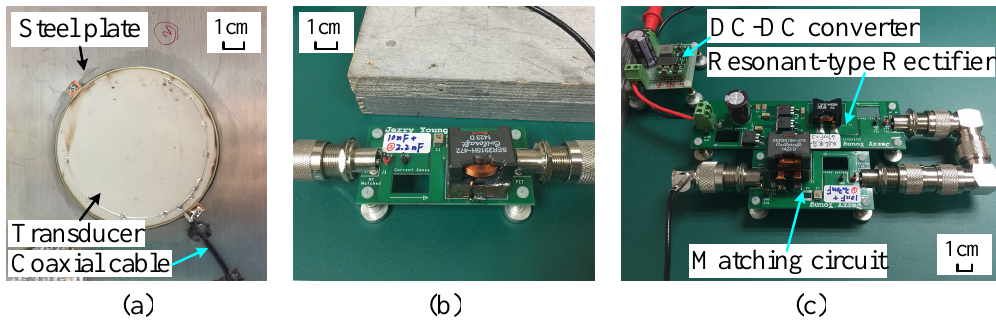
Figure 11. ( a ) One of the transducers; ( b ) TX matching circuit; ( c ) RX matching circuit and AC-DC converter.